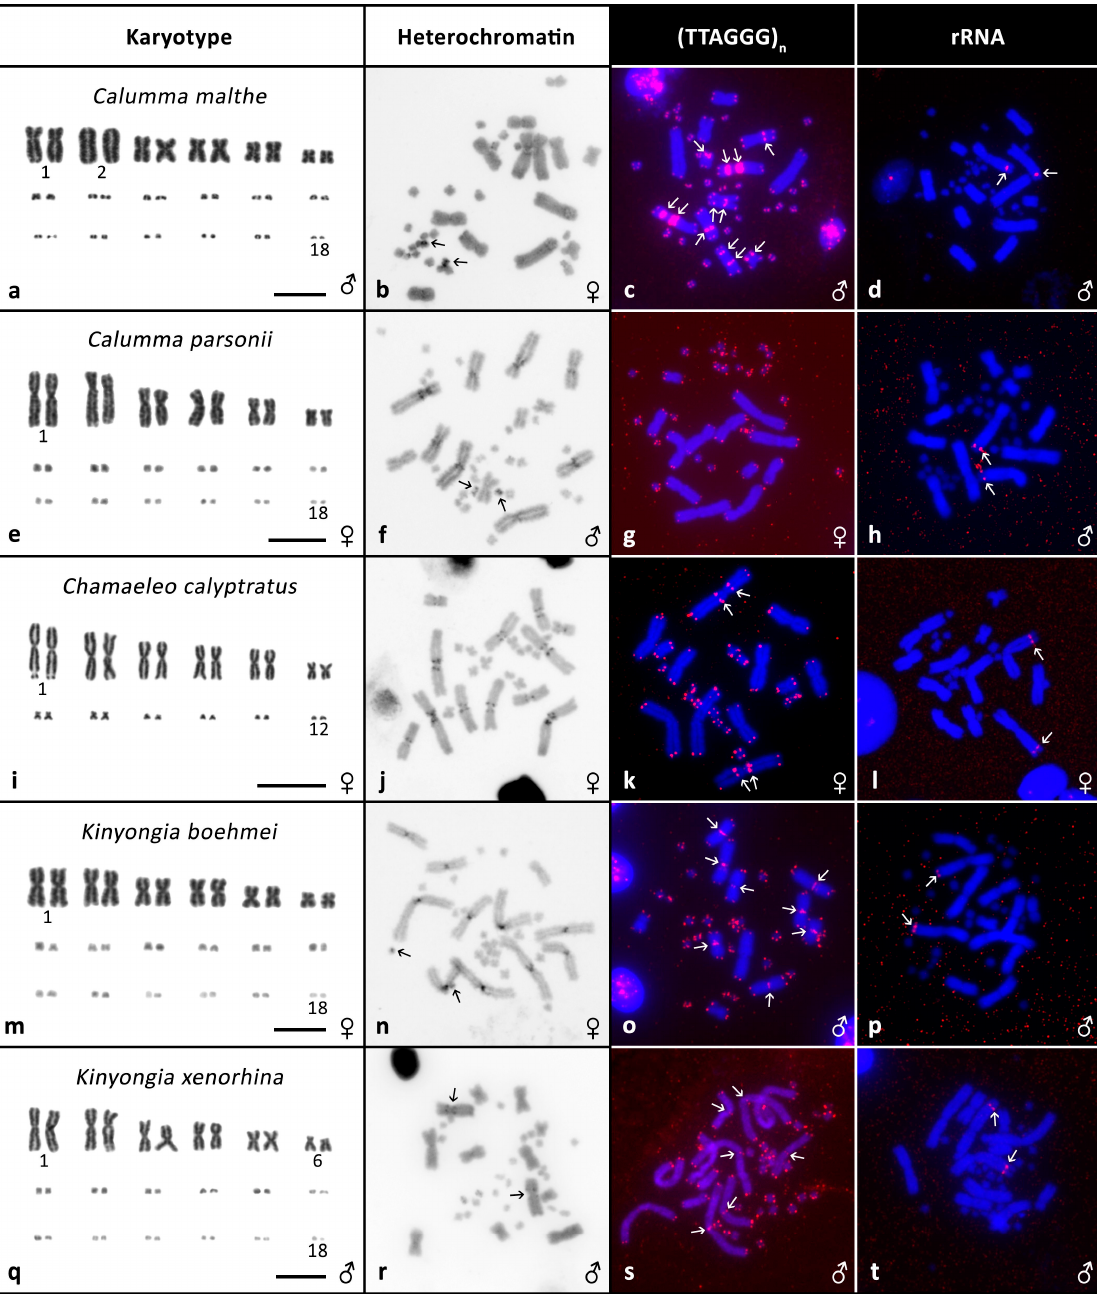
Figure 2 . Cytogenetic data. Giemsa stained karyotypes ( a , e , i , m , q ), C-banding ( b , f , j , n , r ), FISH with telomeric probe ( c , g , k , o , s ) and FISH with rRNA probe ( d , h , l , p , t ) in Calumma malthe , Calumma parsonii , Chamaeleo calyptratus , Kinyongia boehmei , Kinyongia xenorhina . Arrows indicate signals. Rhampholeon temporalis : the karyotype consists of 2n = 22 where 10 chromosomes are